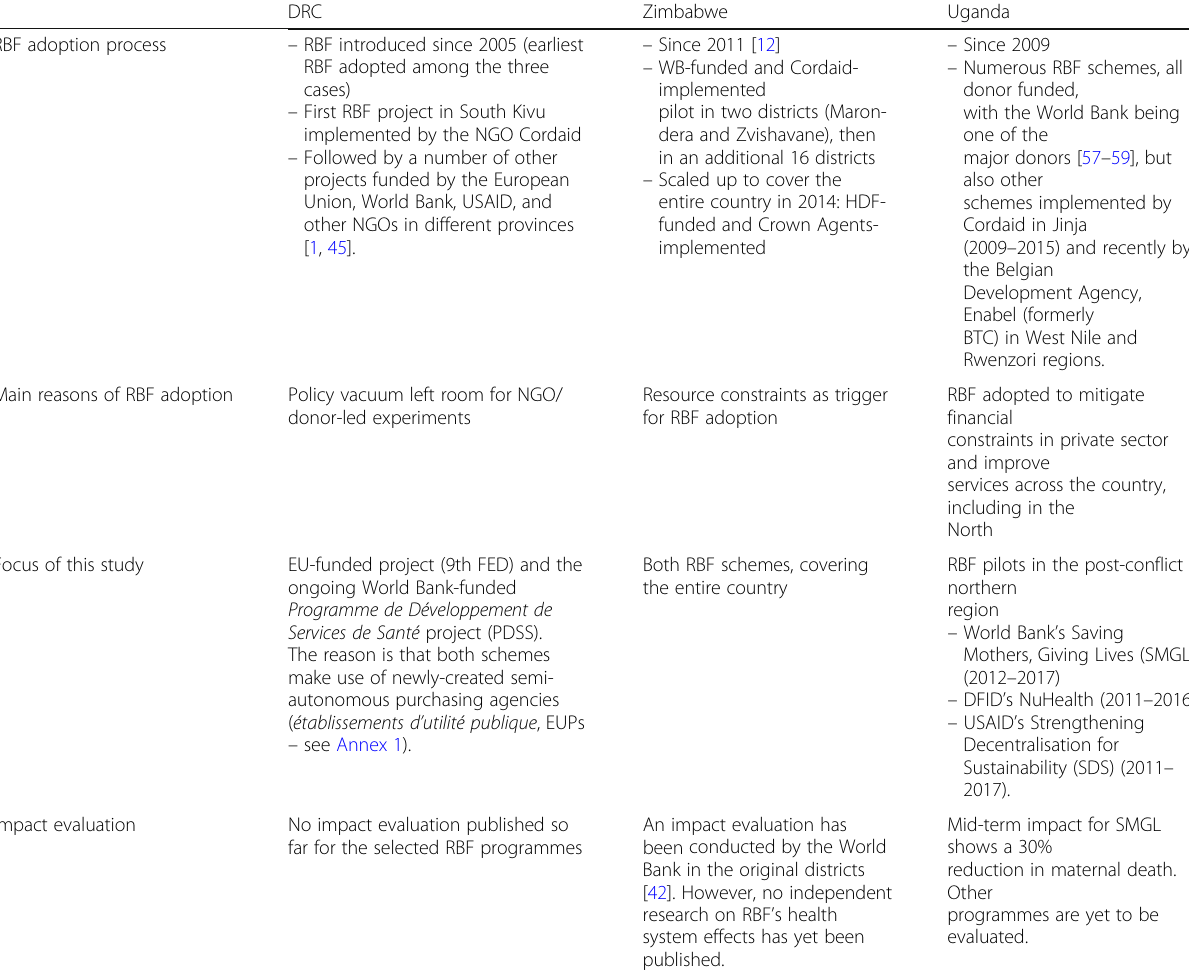
Table 1 Summary of key features of RBF in the case